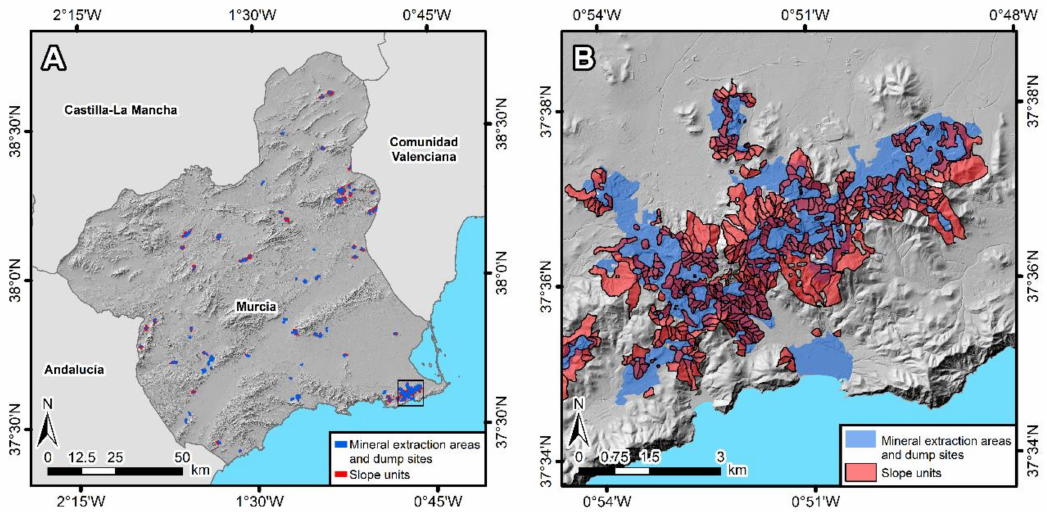
Figure 13. ( A ) Mineral extraction areas and dump sites extracted from the Corine Land Cover 2018 [63] over the region of Murcia, and slope units (SUs) overlapping both classes, obtained with the software r.slopeunits [47], using the optimal values of the input parameters a and c , i.e., ( a , c ) = (10,000 m 2 , 0.10). The black square shows the location of the study area. ( B ) Detail of the mineral extraction areas and dump sites over the study area, and slope units (SUs) intersecting both